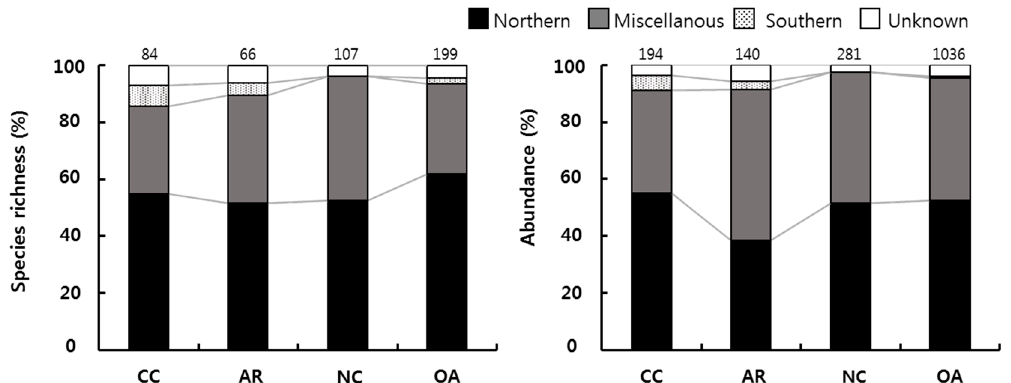
Figure 5. Proportion of species richness and abundance of the functional groups based on the distribution region. The numbers on the bar indicate species richness (number of species) and abundance (number of individuals) in the corresponding treatment. CC: clearcutting area; AR: aggregated retention area; NC: no cutting area; OA: Mongolian oak area.